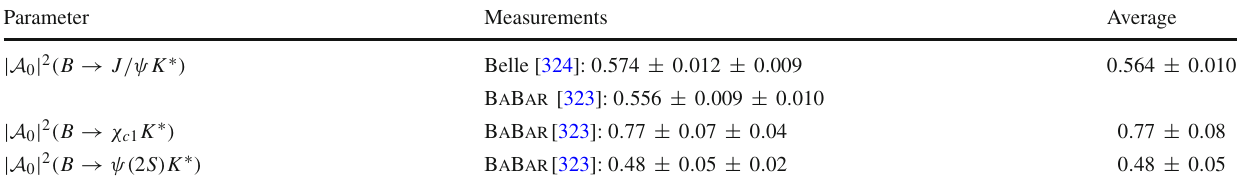
Table 182 Decay amplitudes for longitudinal polarization